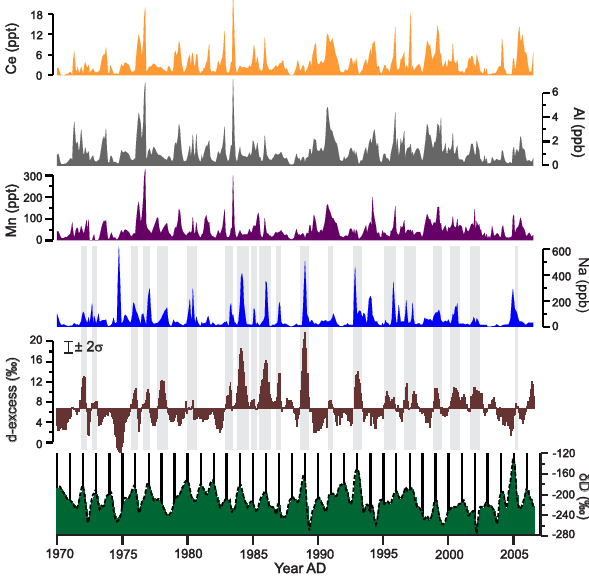
Fig. 4. Stable isotope and chemistry data for the time period 1970– 2006AD of the MES ice core. All the time series have been re- sampled to monthly resolution. Vertical black lines on the δ D plot locate annual layers. Back-diffused δ D data are plotted for compar- ison (dashed black line). The d-excess time series is plotted around the 1970–2006 mean value. δ D analytical error bars are too small to plot, and the d-excess analytical error is indicated. Shaded bars highlight d-excess values exceeding the 1970–2006 mean with as- sociated Na peaks (grey